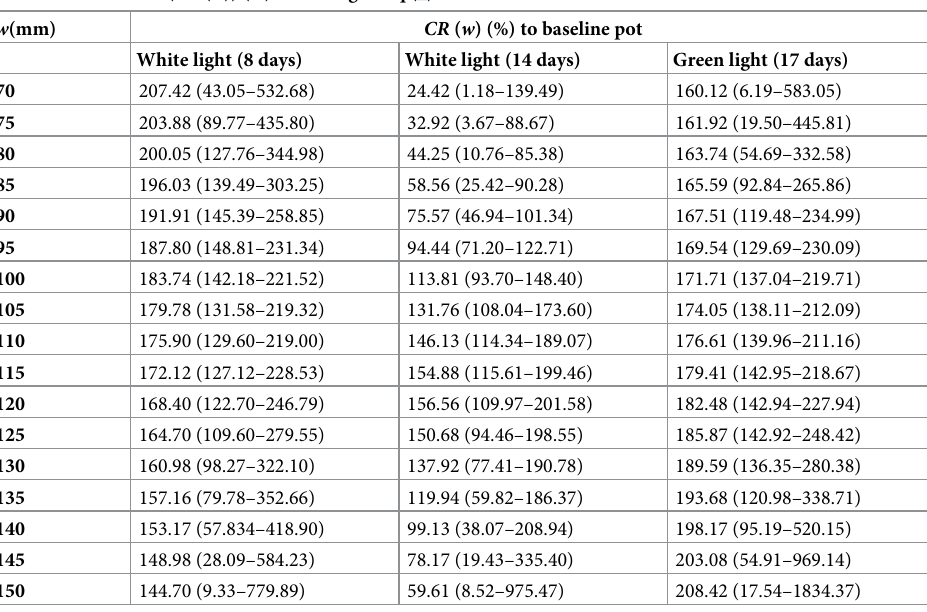
Values in parentheses represent 95% confidence